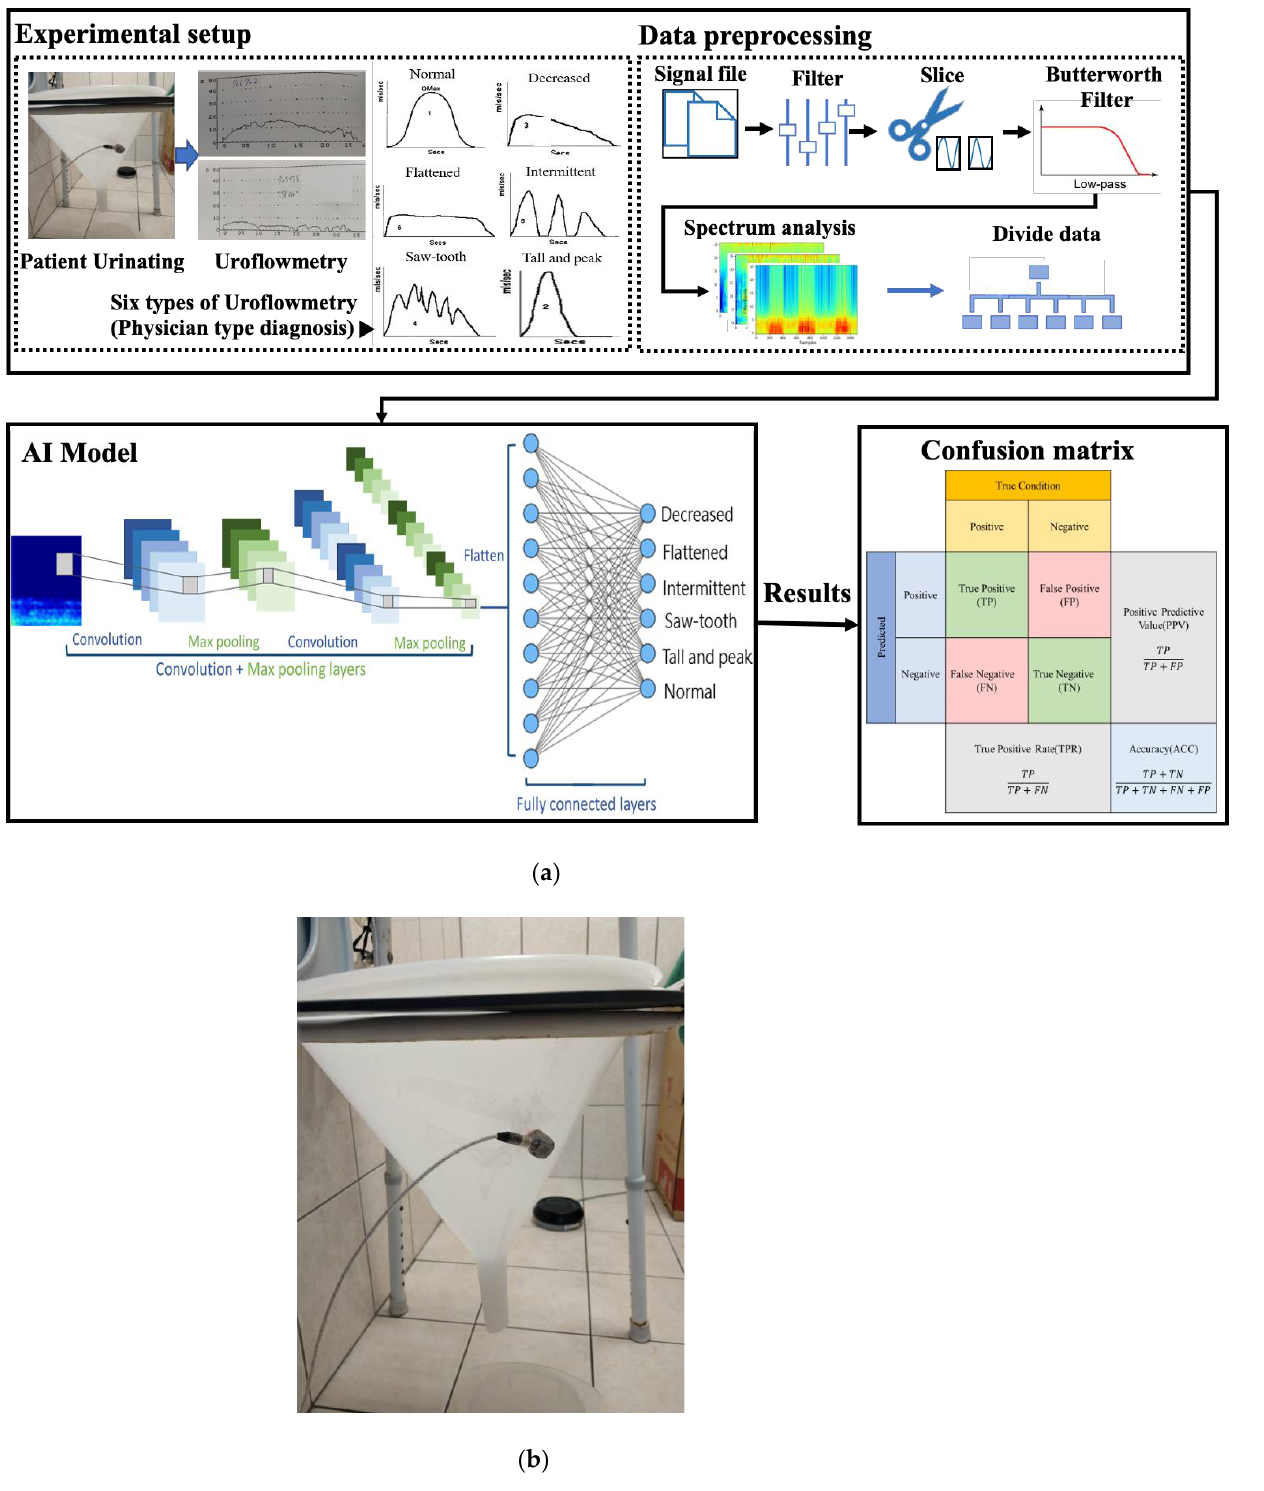
Figure 1. ( a ) The study flowchart and framework. ( b ) The experimental vibration accelerometer attached to the urinal